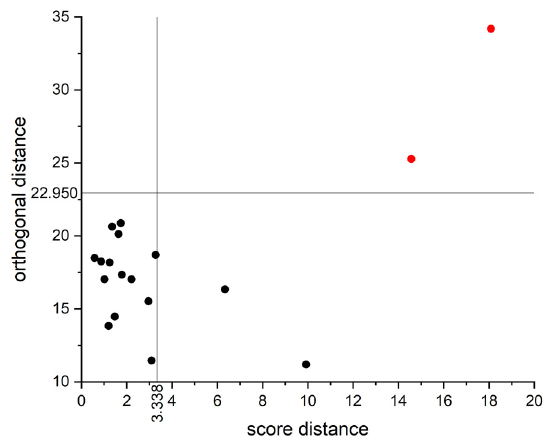
Figure 4. ROBPCA outlier map of CuFeS 2 data in basalt at Echelle spectrometer with 4 components. The robust score distance at 3.338 and the orthogonal distance at 22.950 span the quadrants of the map. Two bad leverages (red) are detected in the first quadrant. Orthogonal outliers are not included in the data set (2nd quadrant).